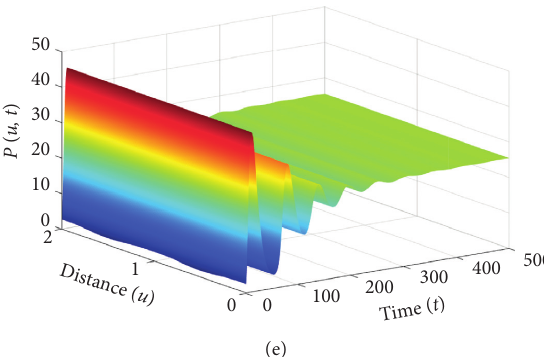
� ( 833 . 333 , 5 . 556 , 5 , 0 , 25 . 556 ) is asymptotically stable. (a) Target > 1 and R ≤ R ), the equilibrium Ω 2 1 2 3